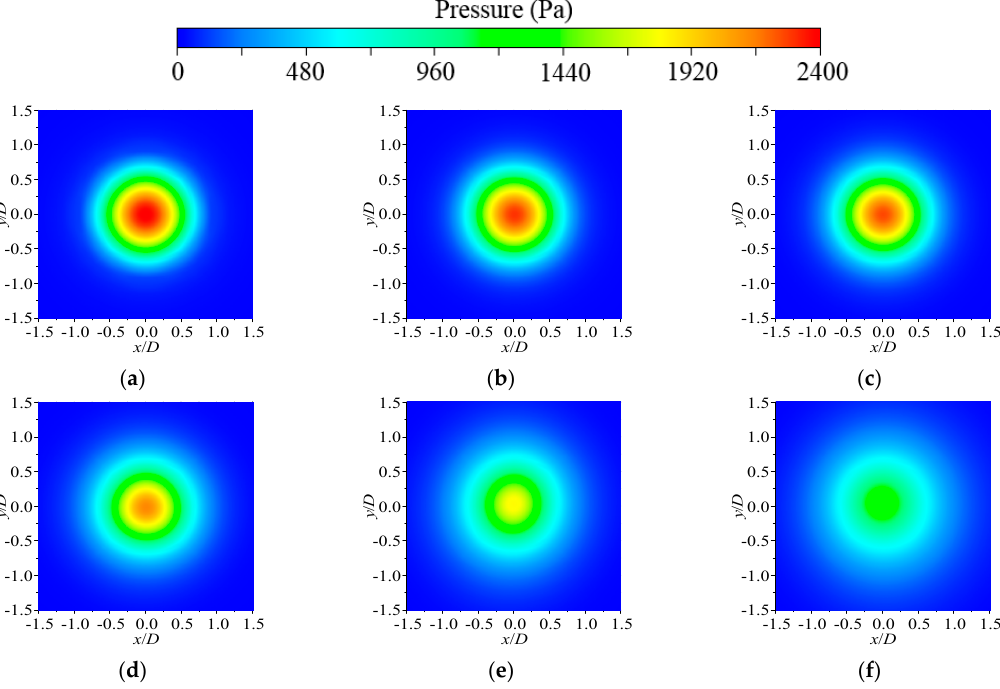
Figure 14. Pressure contour of the plane ( oxy plane) of jet at various impinging height:( a ) H / D = 1; ( b ) H / D = 2; ( c ) H / D = 3; ( d ) H / D = 4; ( e ) H / D = 6; ( f ) H / D = 8.